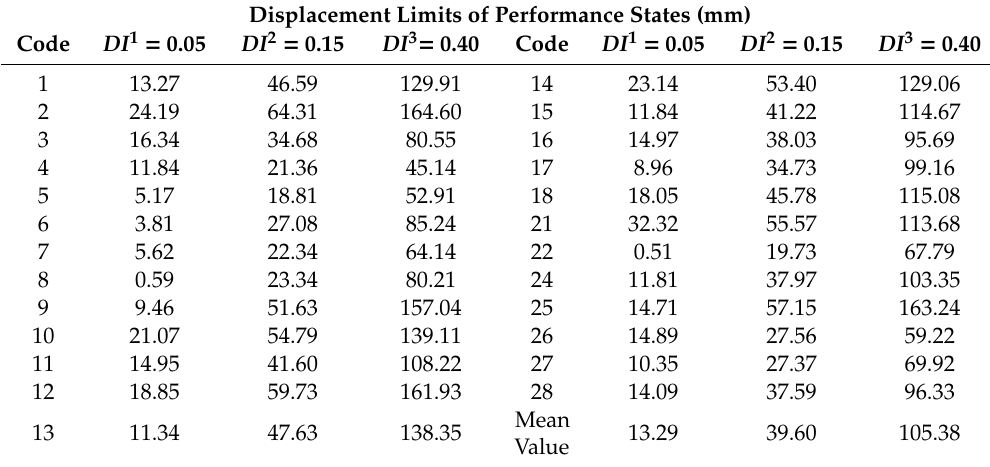
Table 5. Residual displacement-based level limits under various earthquakes.